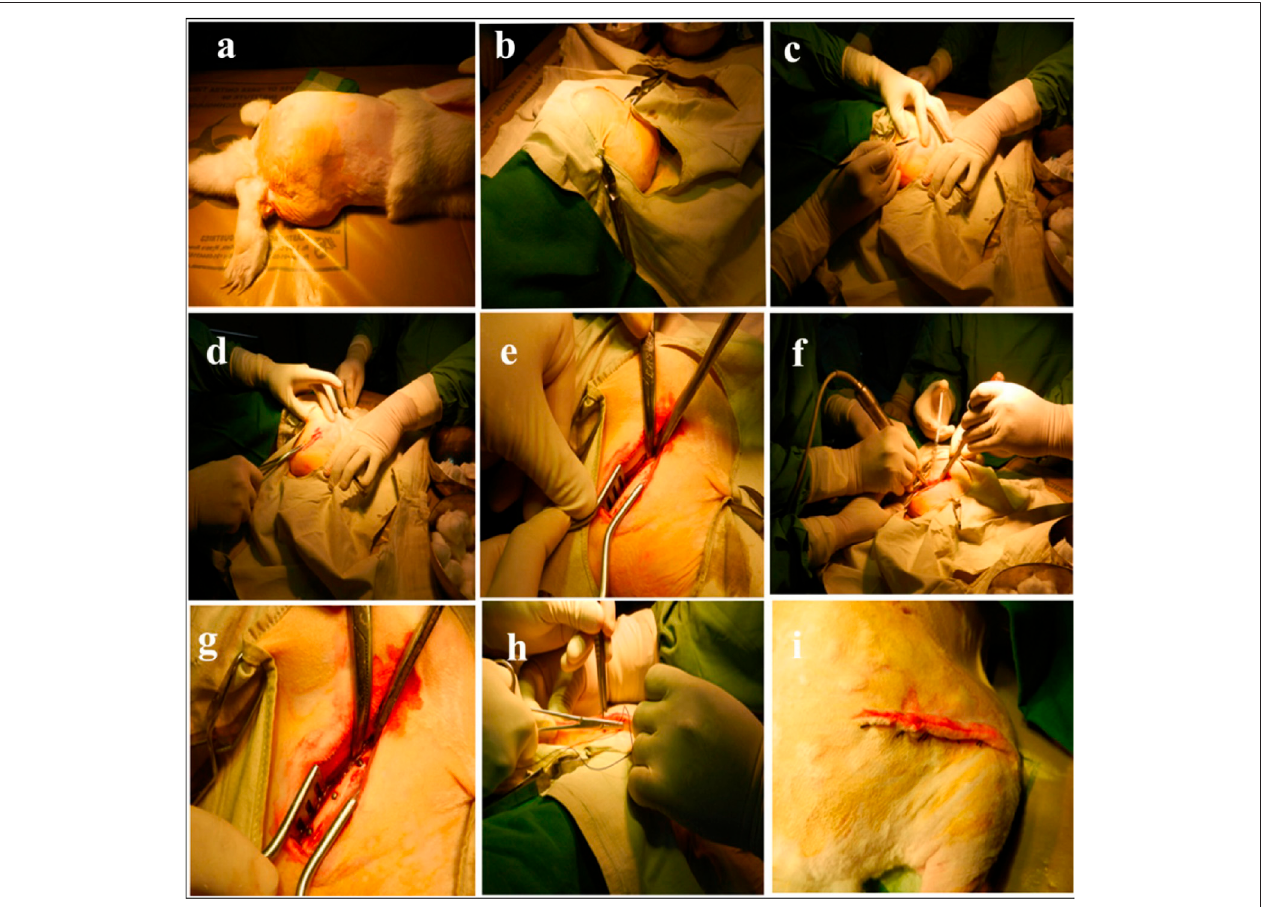
FIGURE12| OrthopedicapplicationsfortheTiO 2 -Nb 2 O 5 nanoporousmixedmetaloxideboneimplantmaterials.AdaptedfromVandanaetal.(2021).Copyright© 2020ElsevierB.V. (A,B) Animalsthatlieontheirside, (C,D) Theexposedfemoralcortex, (E) Threeholesspaced1cmapart, (F,G) Materialimplanted, (H,I) Suturewith sterile